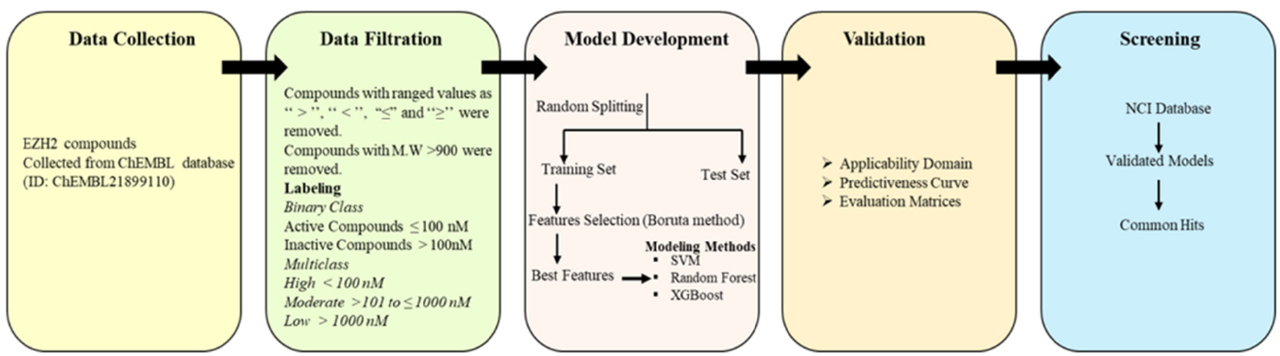
Figure 1. A framework guiding the development and evaluation of a predictive model for EZH2. The stages are: (1) Data collection, (2) Data cleaning and threshold setting, (3) Development of models, (4) Validation of the model and analysis, (5) Screening of chemical libraries using the validated models. Table 1. List of selected descriptors used in model building.